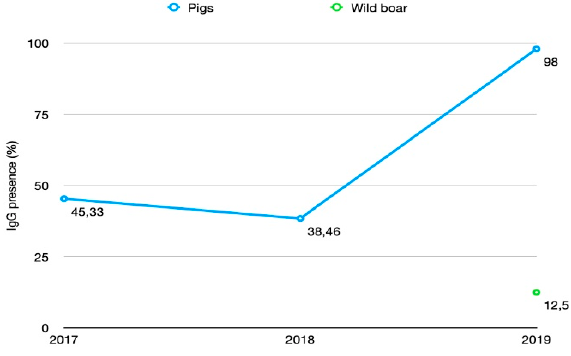
Figure 2. HEV IgG positive test results by year.